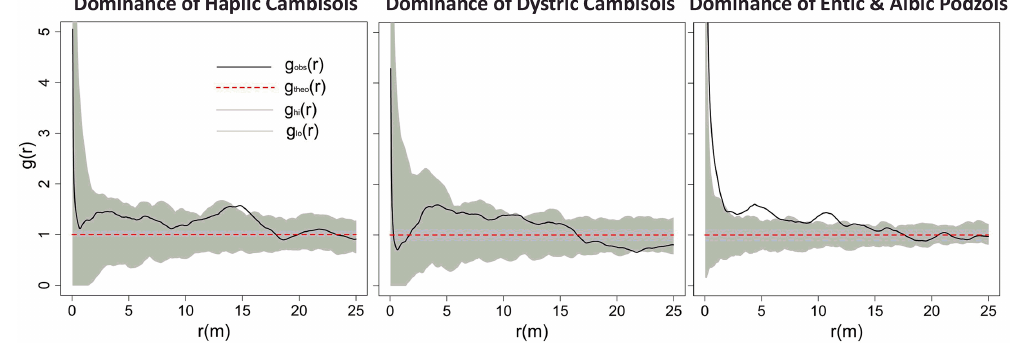
Figure 8. Spatial patterns of uprootings at sites dominated by various soils. Significant spatial distributions were determined through 199 Monte Carlo simulations of the null model of complete spatial randomness. If the value of g hi (r) is larger than the value of the g hi (r) then the uprootings show significant clustering. If the g obs (r) is smaller than value of the g lo (r) then the recruits show a regular distribution. In the grey zone, we cannot reject the null hypothesis of complete spatial randomness. The variable r refers to distance (for details see Sect.